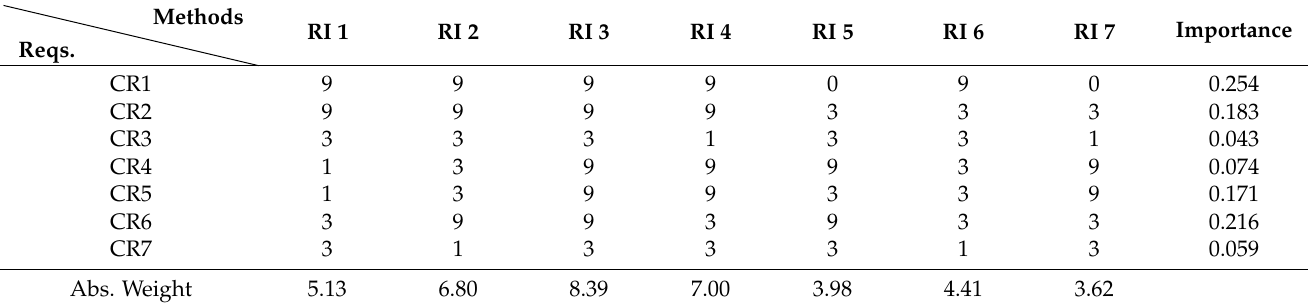
Table 3. Result of the QFD